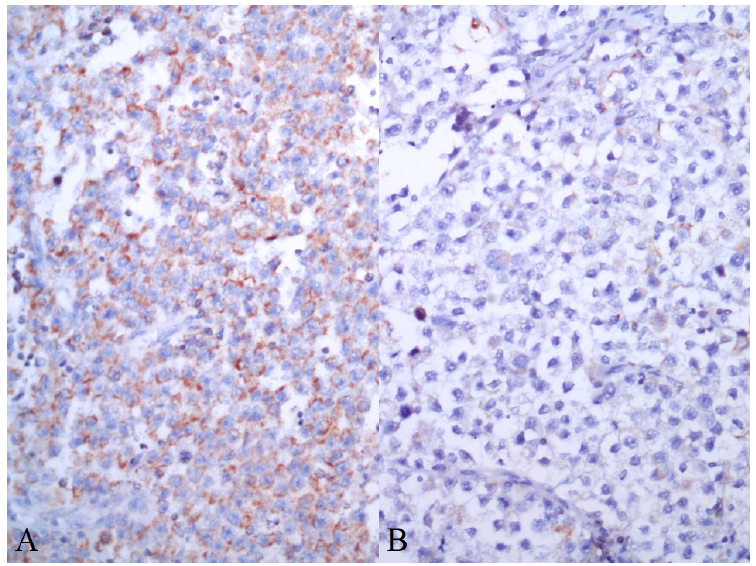
Figure 7. High ( A ) and low ( B ) AIF expression in two different samples of seminoma (immunoperoxidase technique, 200×) .